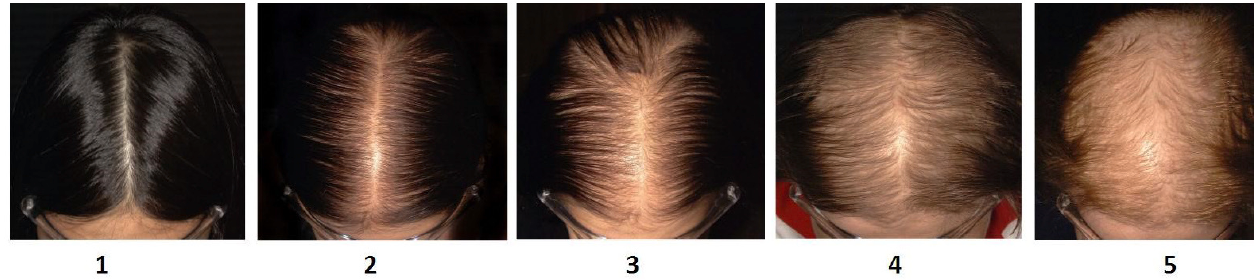
Figure 2. Sinclair Scale for assessment of mid-frontal scalp hair density 17